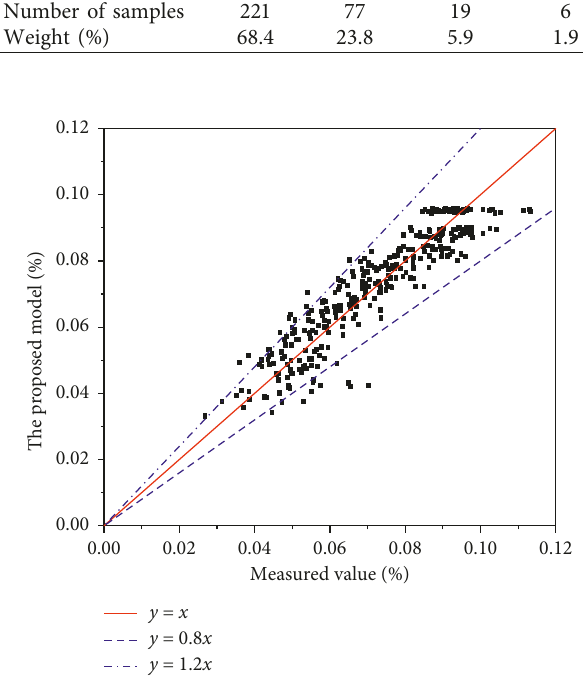
Figure 5: Comparison of the chloride content at different depths between the calculated data using the proposed model (equations (14a) and (14b)) and the field measurement